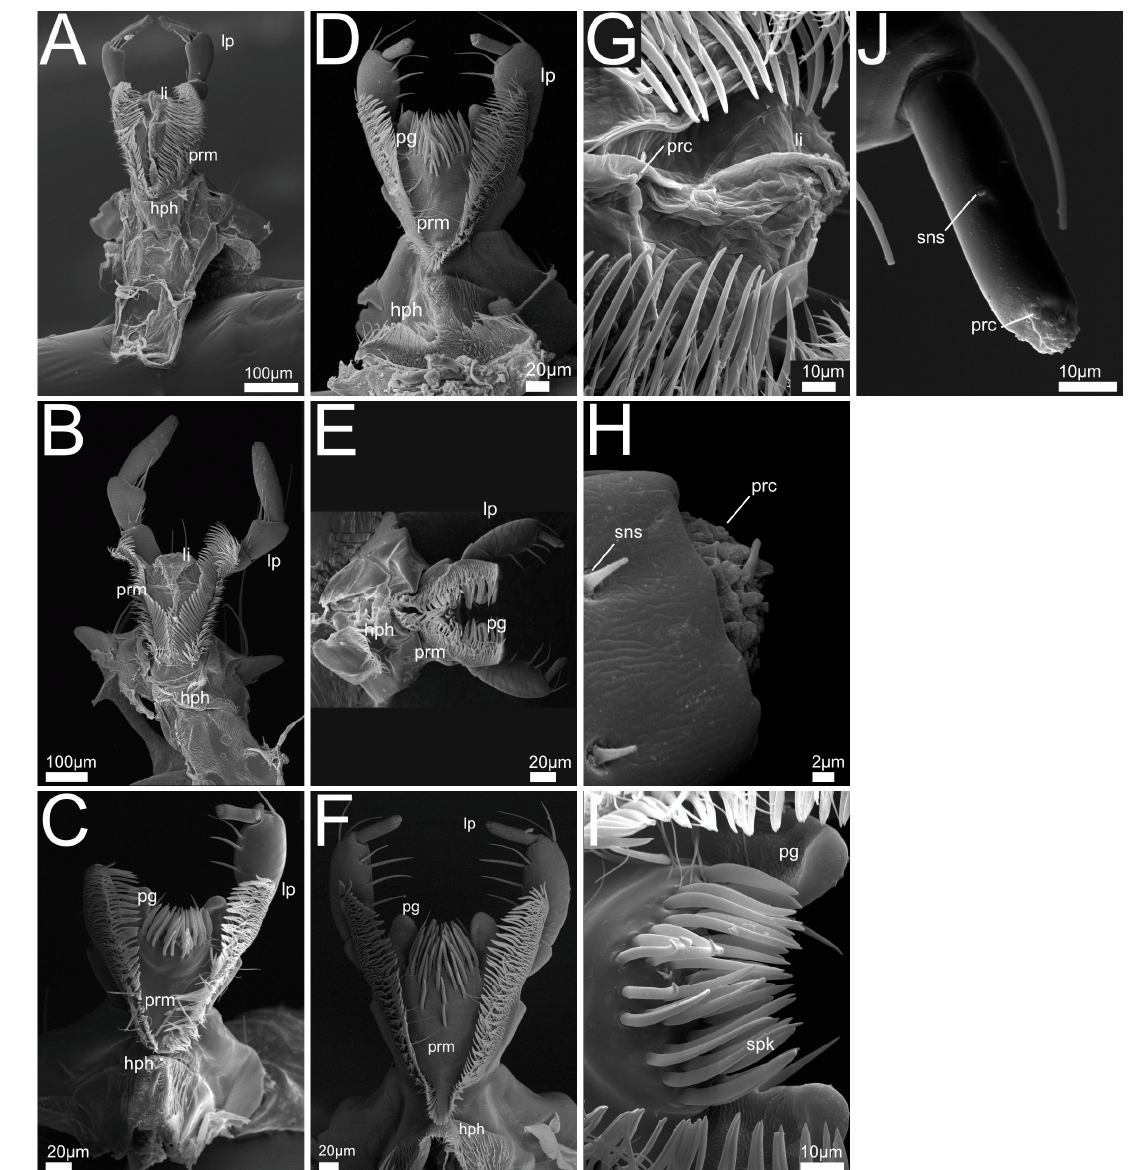
Figure 13. SEM views of Xantholinini, Othiini and Stilicina labium-hypopharynx. Images A – F dorsal aspect of labium-hypopharynx, G – J with detailed views of apical palpomeres, ligula and receptors, ( A ) Gyrohypnus fracticornis ; ( B ) Othius punctulatus ; ( C ) Rugilus erichsonii ; ( D ) R. mixtus ; ( E ) R. orbiculatus ; ( F ) R. rufipes ; ( G ) G. fracticornis , dorsal aspect anterior prementum and ligula; ( H ) O. punctulatus , apical end of labial palp; ( I ) R. erichsonii , dorsal aspect of anterior prementum and ligula; ( J ) R. rufipes , apical segment of labial palp. Abbreviations: hph: hypopharynx; li: ligula; lp: labial palp; pg: paraglossae; prc: papilliform receptor; prm: prementum; spk: spike-like sensilla; sns: sensilla.